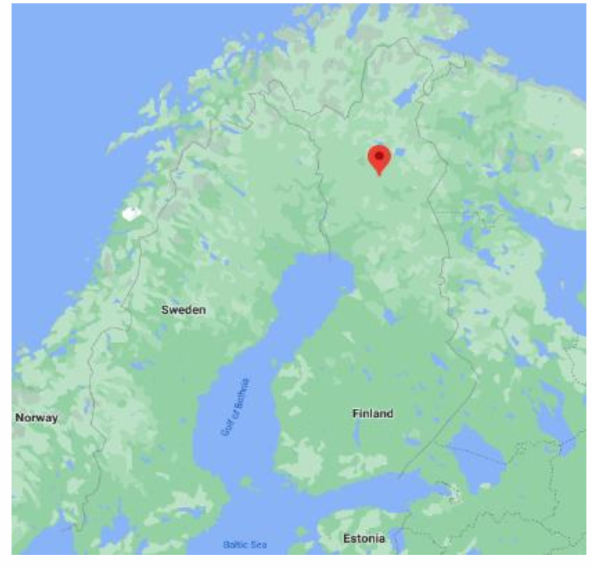
Figure 4. Testing location.